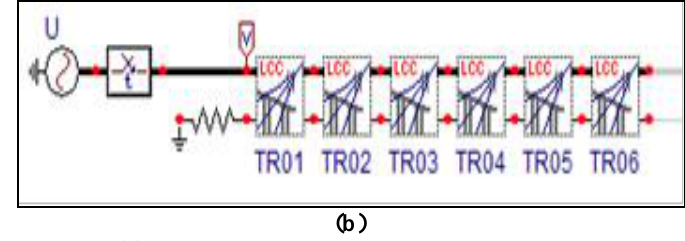
Figura 4: (a) Detalle del ajuste empleado en al ATP para un tramo de línea . (b) Equivalente Circuital de una línea no uniforme representada por 6 tramos de línea en cascada, de parámetros